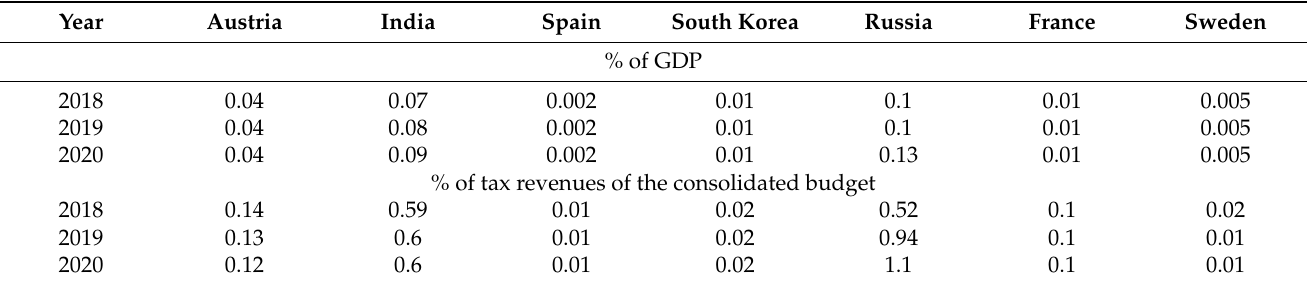
Table 1. Tax expenditures stimulating the energy sector development in selected OECD countries and key OECD partner countries from 2018–2020.